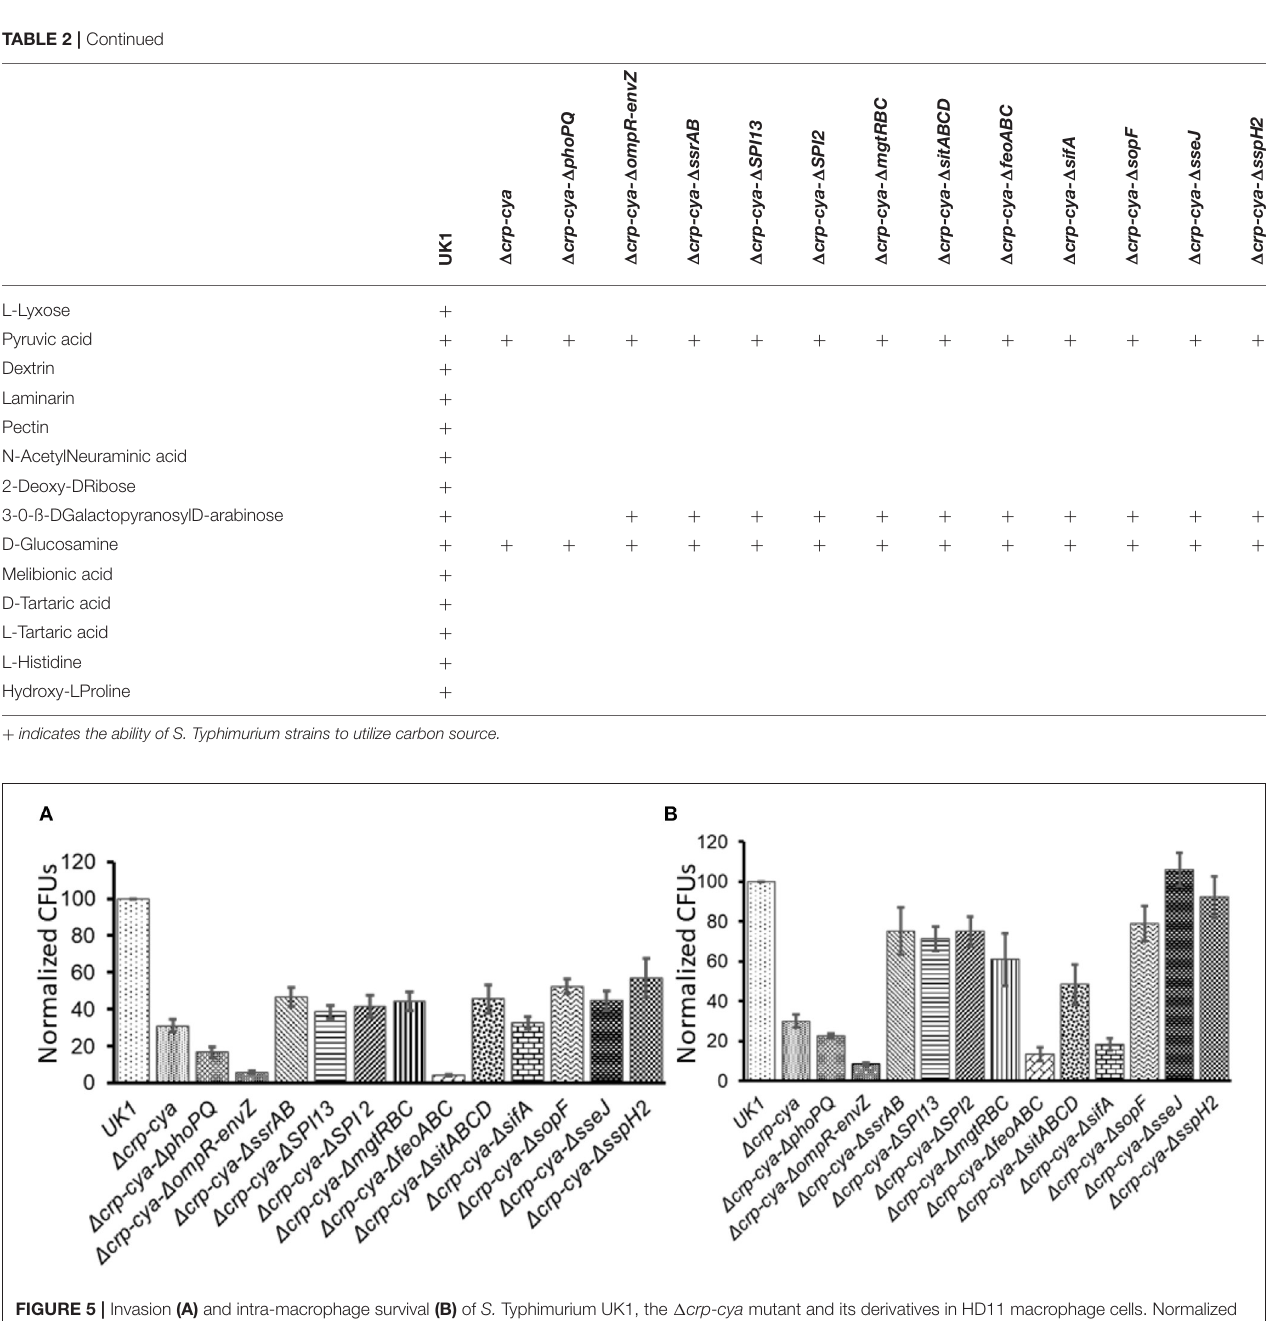
intronic regions and 11.5–12.6% mapped to intergenic regions. The coefficients of determination ( R 2 ) between replicates and samples ranged from 0.98 to